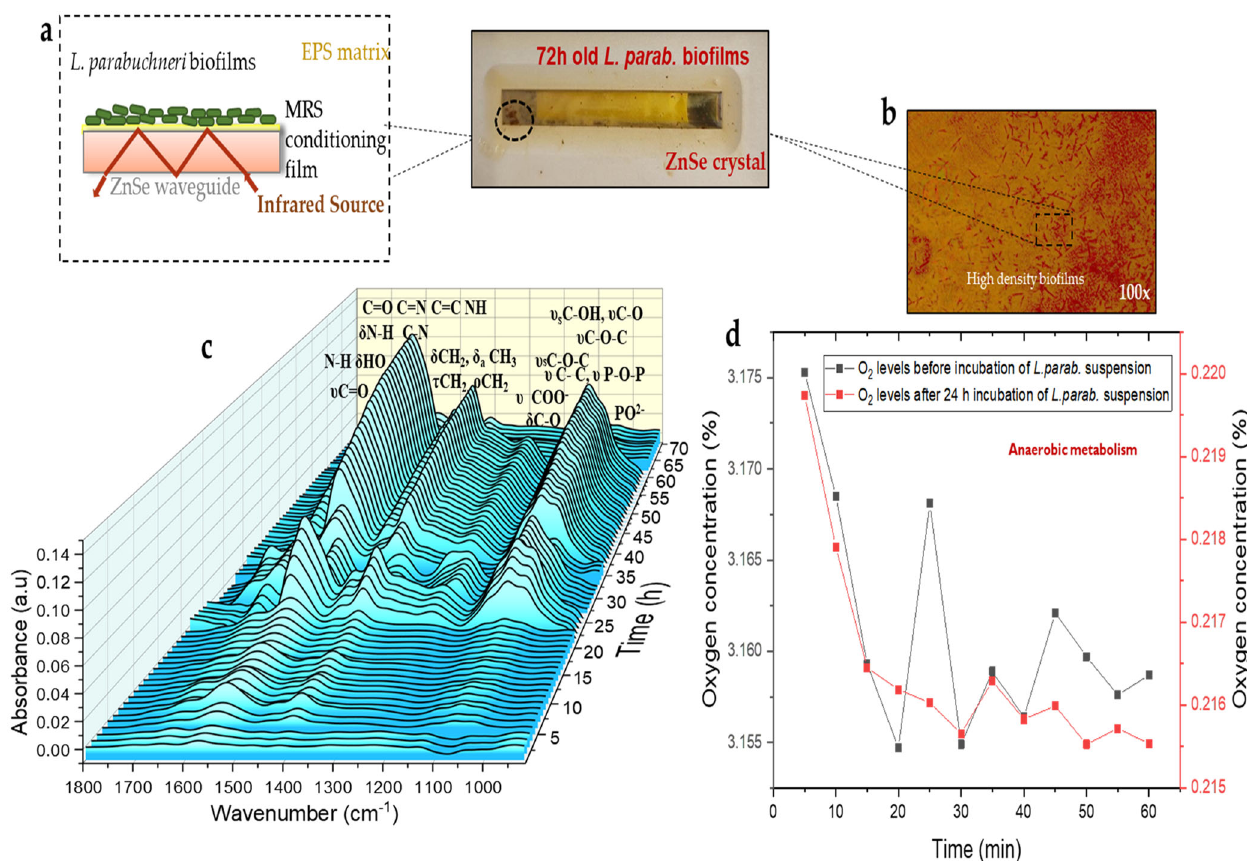
Fig. 5 Bio fi lm evolution. a Scheme of the deposition of L. parabuchneri bio fi lms at the ATR waveguide surface after the conditioning fi lm was formed. b Optical image of L. parabuchneri bacterial bio fi lm attached to the surface of the ATR waveguide during 7 days of IR measurements at fl ow-through conditions. c 3D plot of IR-ATR spectra vs. time revealing the molecular changes occurring during 72 h of bio fi lm development. d Concentration pro fi les of oxygen prior to and after inoculation of the L. parabuchneri suspension.